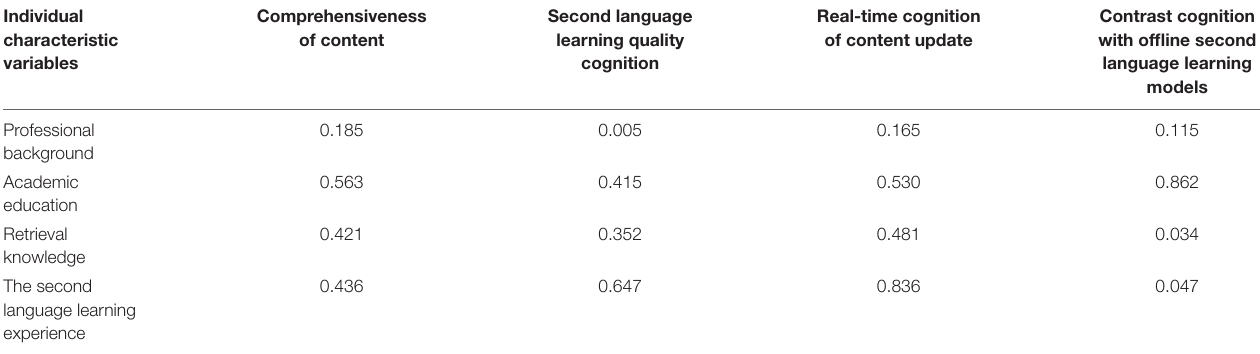
TABLE 3 | Test of variance of score of influence of knowledge experience on content cognition of second language learning model.